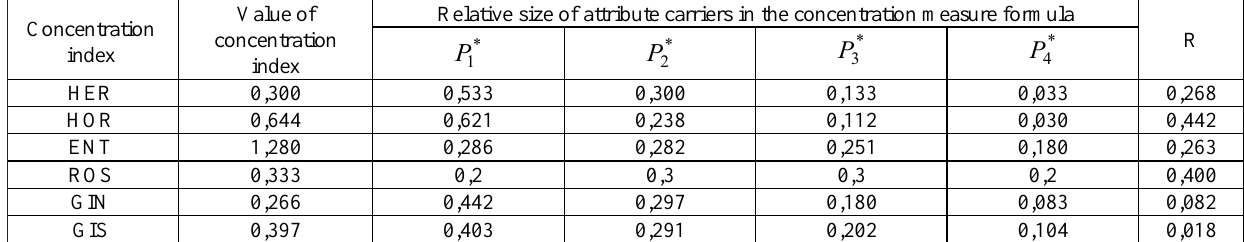
Table 3. Comparison of the accuracy of concentration measures